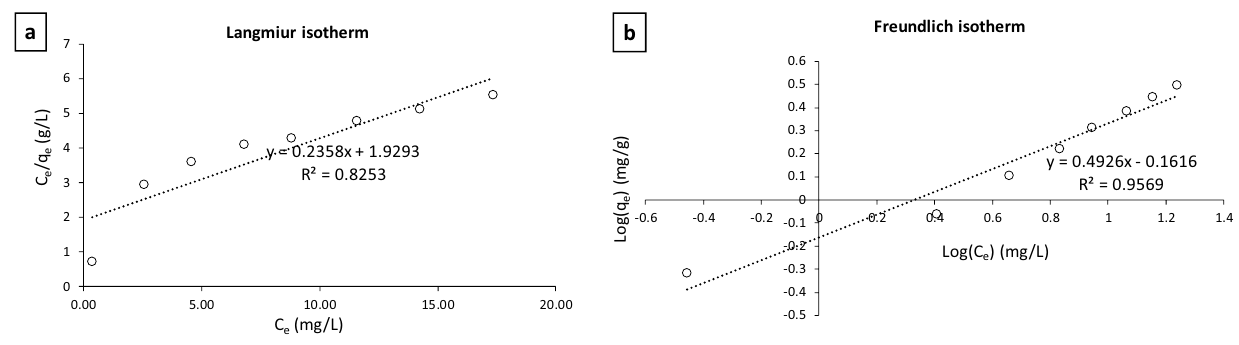
Fig. 6 Isotherm studies for the adsorption of MB dye onto nZVAl: a Langmuir model (linear form), b Freundlich model (Linear